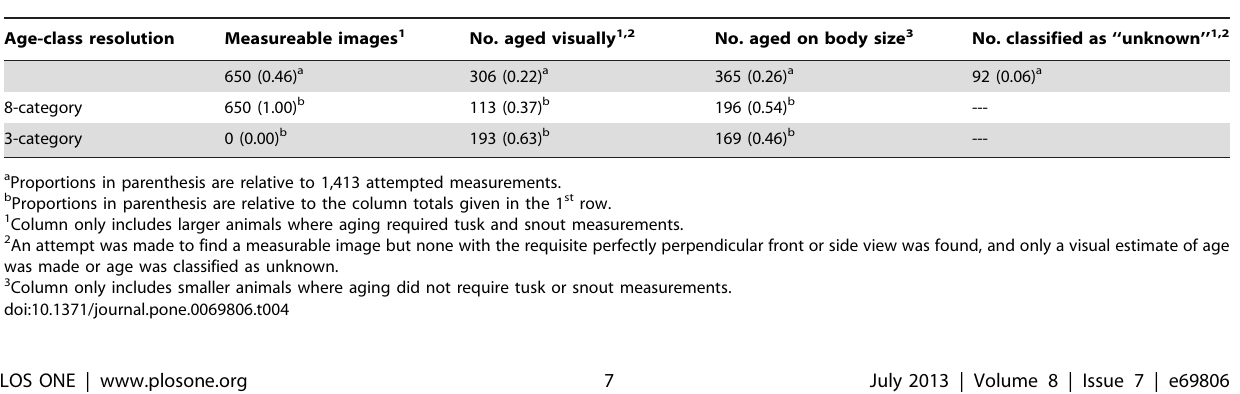
(Table 4). Another 365 (26%) were small calves that could be aged accurately without measurements. Ninety-two (6%) were larger individuals ( $ 3 yrs) that provided no view of their tusks and snout and their age was classified as ‘‘unknown’’ (Table 4). In 2011, we recorded whether age was determined in the reference image for 1,543 individuals in 39 of 40 hold sequences. We aged 762 (49%) in the reference image while the other 781 (51%) could only be aged by searching the remaining hold sequence for an age-able head profile. We found measurable head profiles more often when searching hold sequences, with 39% and 45% of final ages based on measurements for reference and non- reference images respectively. For animals aged in non-reference images, an average of 15 sec (std. dev. =12 sec, max= 82 sec) of video separated the reference image from the eventual age-able image with 95% of ages assigned in # 40 sec either side of the reference frame. determinations, 22% (29/134) of the 8-category and 4% (6/152) of Table 4. Numbers of walruses selected for measurement-based aging and resolution of age classifications from hold sequences recorded in 2011.